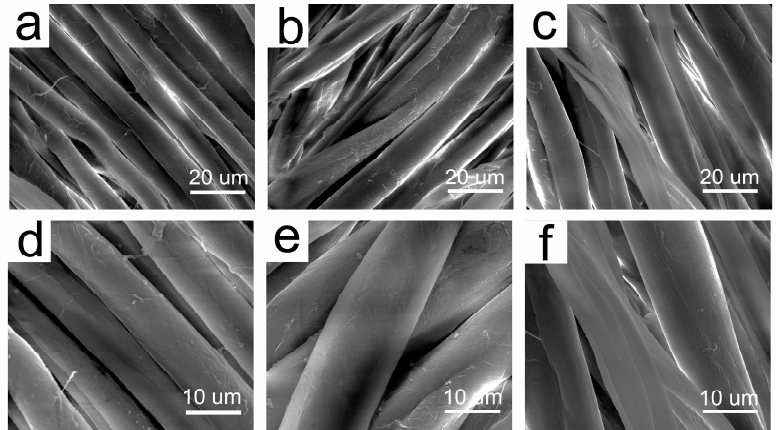
Figure 5. SEM images of different cotton fibers: ( a ) raw cotton, ×3000; ( b ) uncationized cotton, ×3000; ( c ) cationized, ×3000; ( d ) raw cotton, ×6000; ( e ) unmodified, ×6000; and ( f ) modified, ×6000.